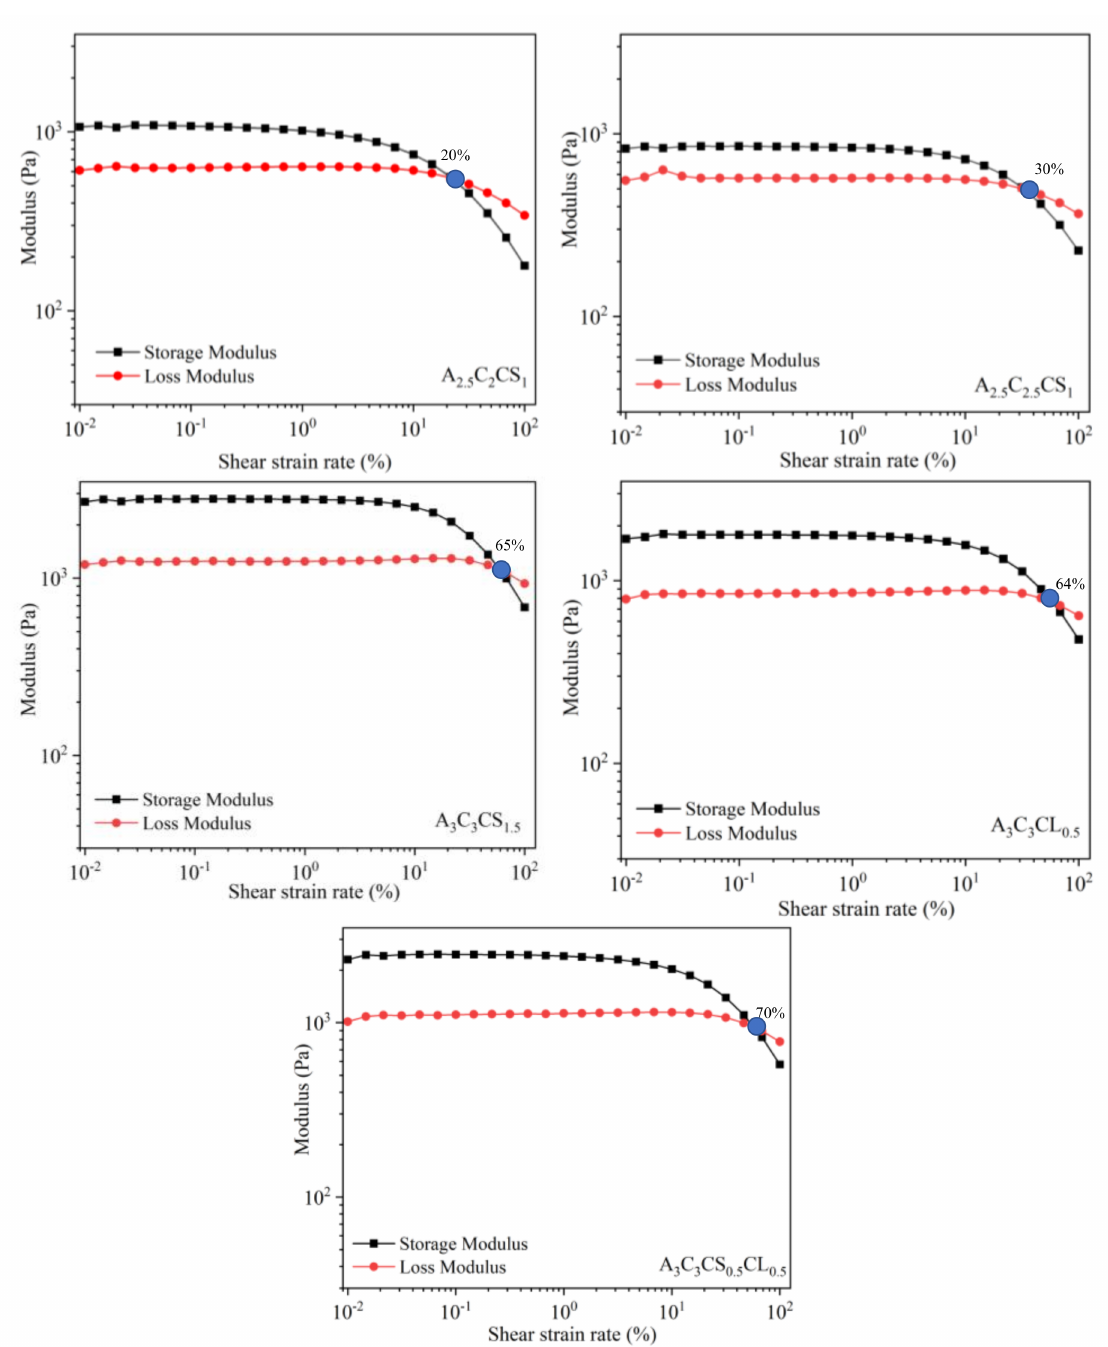
Figure 6. Storage and loss modulus and corresponding gelation point for various compositions. Similar scale is considered ranging from 0.009 to 125% along X -axis and 30–3500 Pa along Y -axis for all